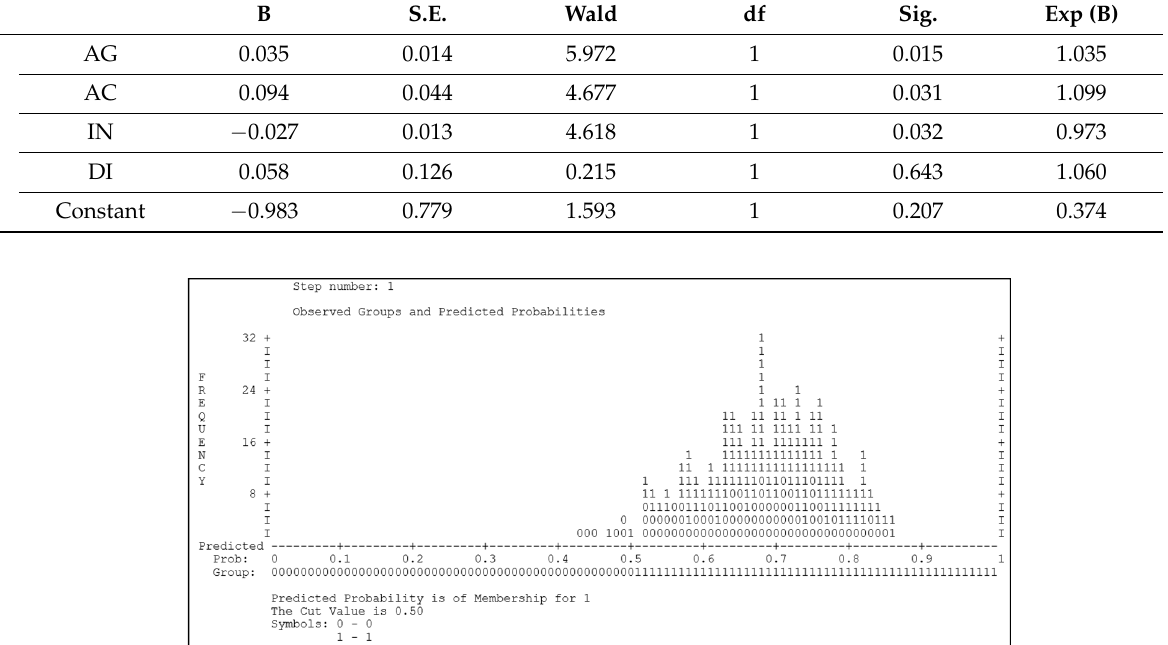
Table 15. Data on business results (2017 − 2020).